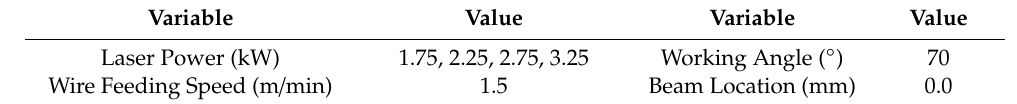
Table 8. Welding conditions of Step 1 (laser power change, 4 cases).